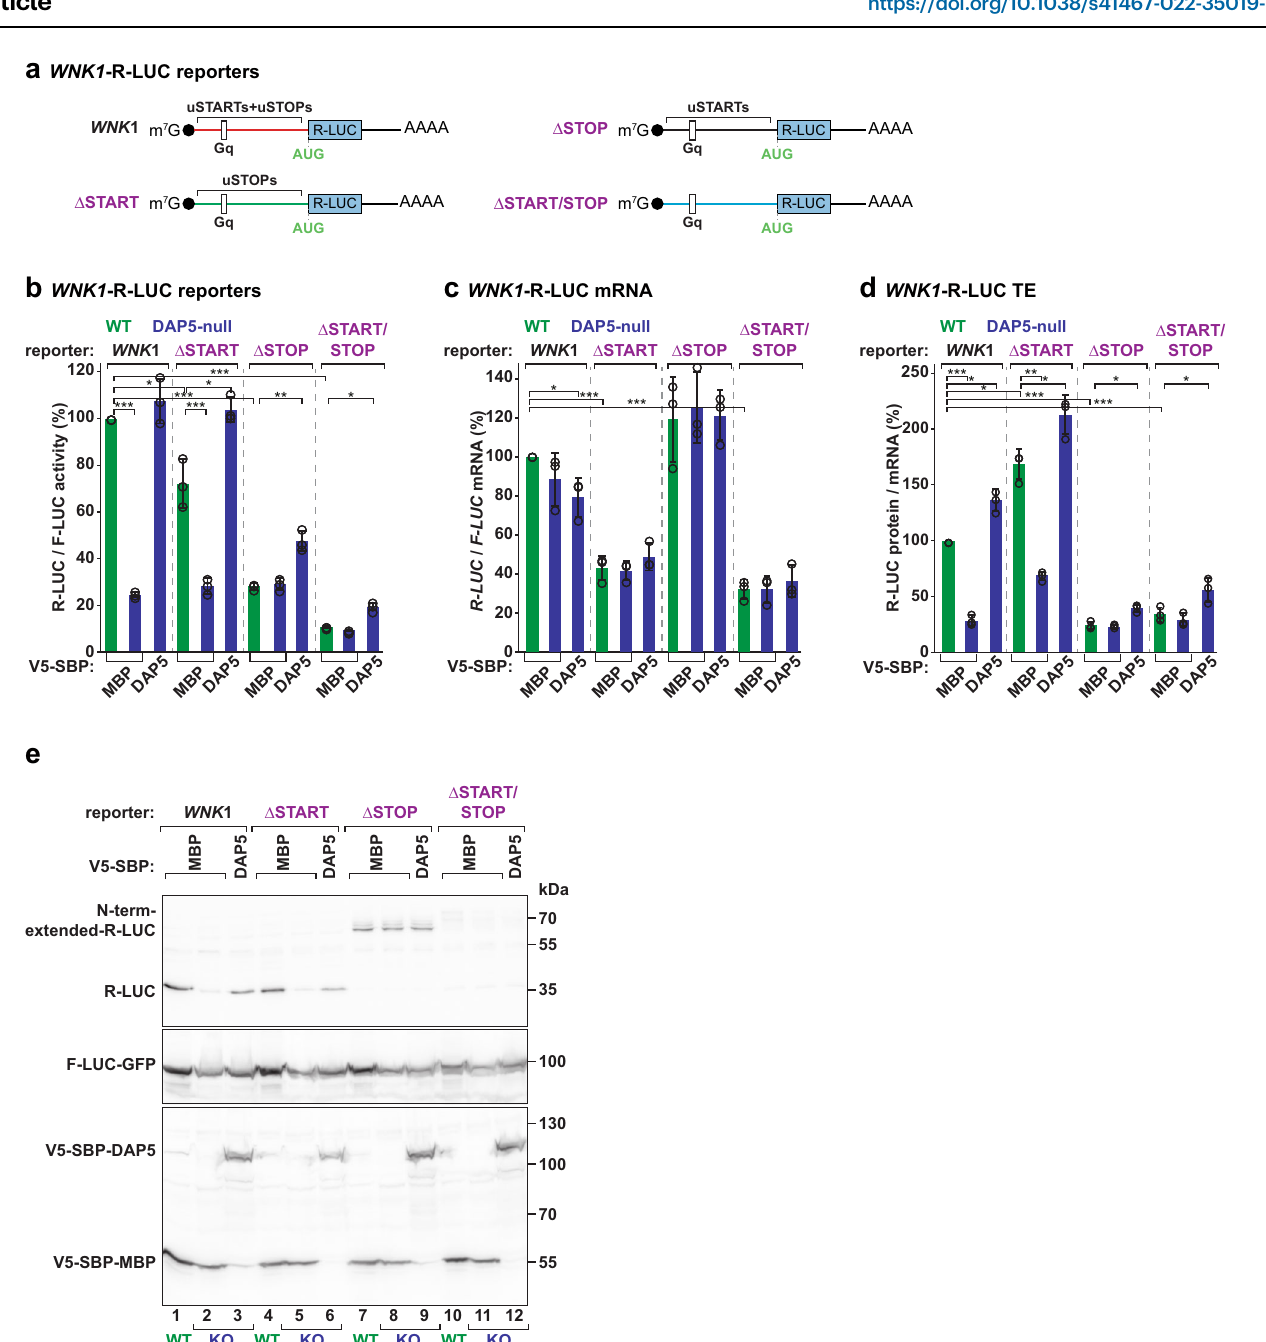
Fig. 5 | DAP5 does not promote leaky scanning. a Schematic representations of the WNK1 -R-LUC reporters without AUG and near-cognate start codons (uSTARTs, Δ START), termination codons (uSTOPs, Δ STOP), or both uSTART and uSTOP codons ( Δ START/STOP) in the 5 ′ leader. b – e WT and DAP5-null cells were trans- fected with plasmids expressing WNK1- R-LUC reporters, V5-SBP-MBP or V5-SBP- DAP5, and F-LUC-GFP. Following transfection, luciferase activities were measured ( b ) and mRNA levels were determined by RT-qPCR ( c ). R-LUC activity and mRNA levels were normalized to the transfection control F-LUC-GFP and set to 100% in